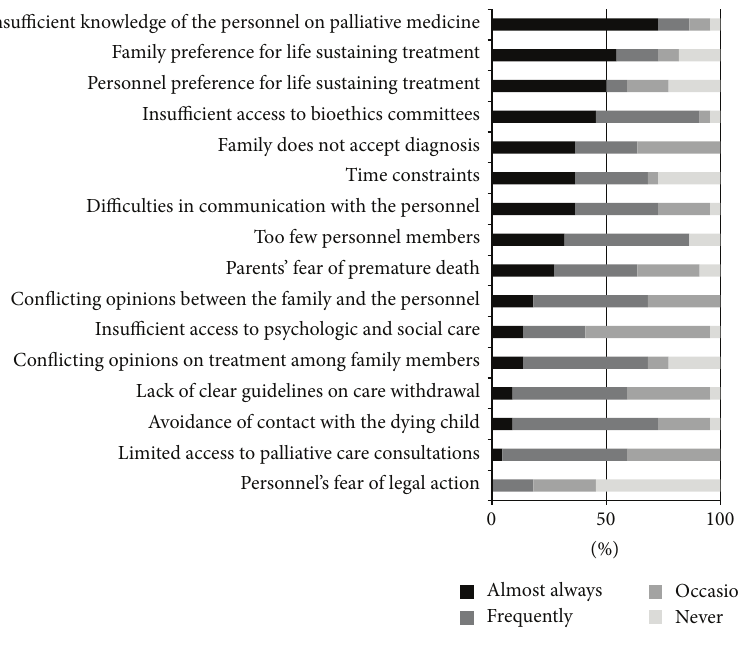
Figure 2: Barriers pointed out by